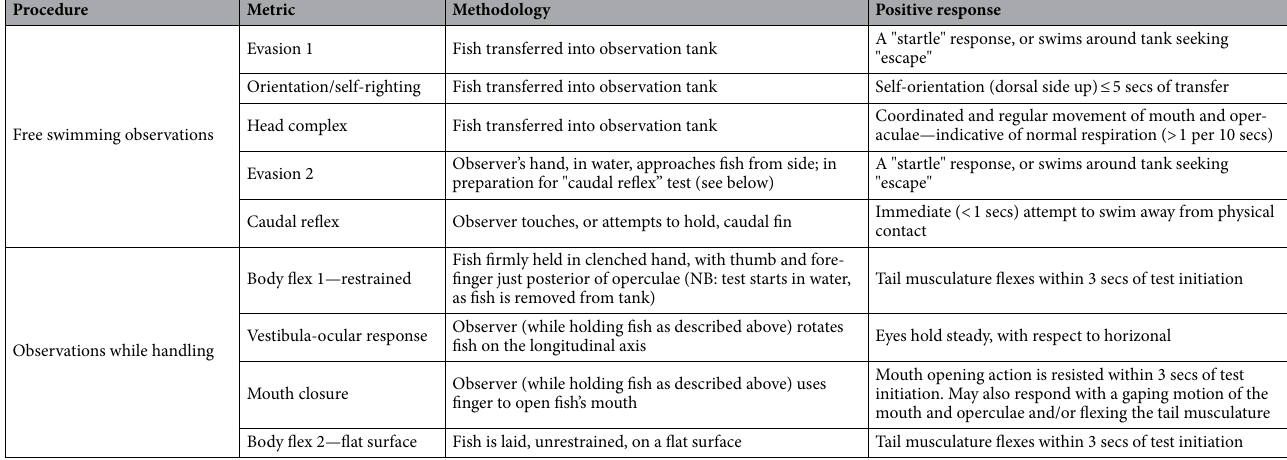
Table 2. Criteria used to assess the vitality of Atlantic mackerel ( Scomber scrombrus ) during crowding